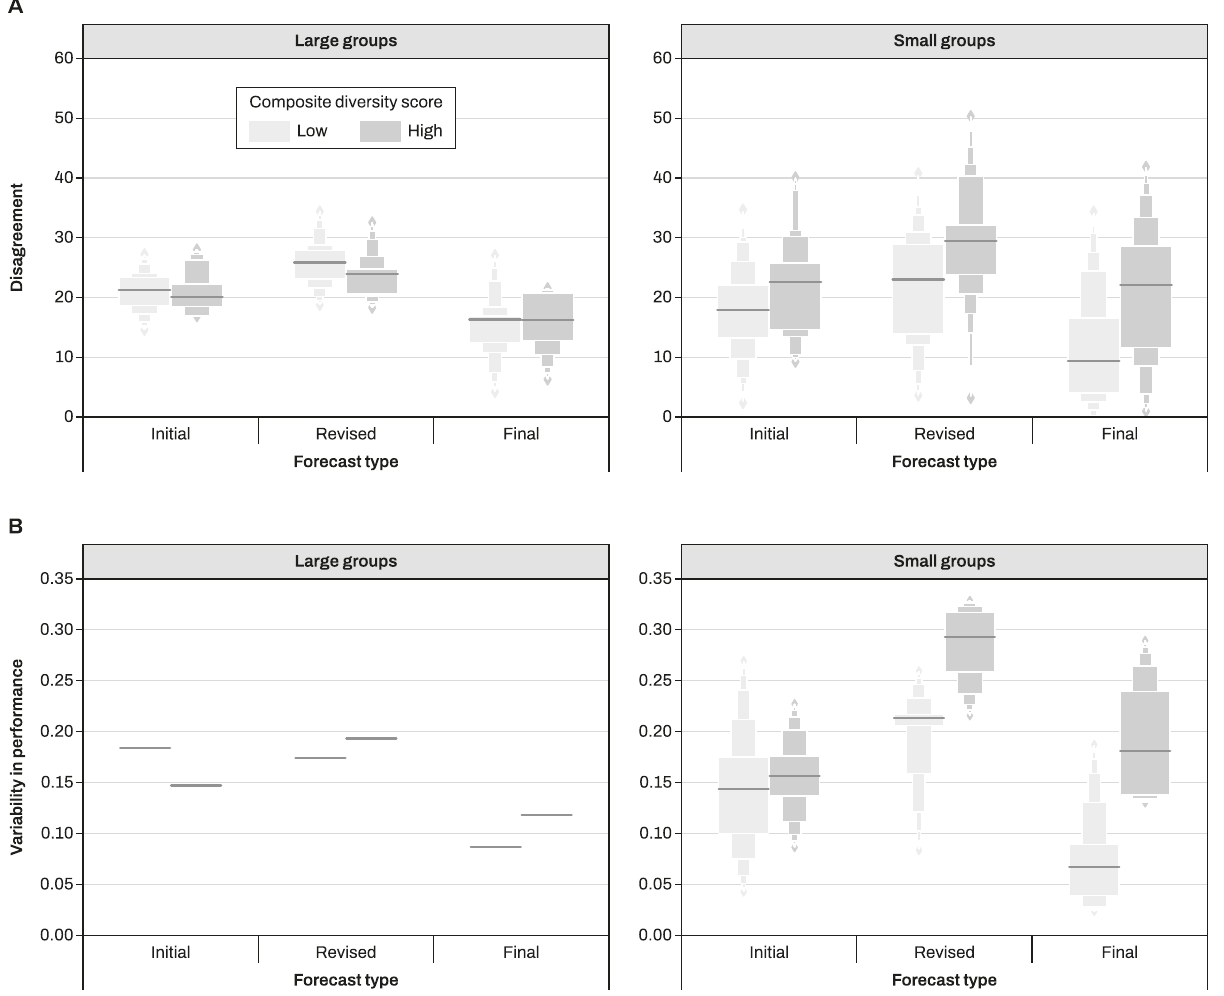
Fig. 4 Disagreement and variability in performance. A Distributions of opinion disagreement as a function of forecasting stage, group trait diversity and group size. Opinion disagreement is calculated as the standard deviation over group members' forecasts. B Performance variability as a function of forecasting stage, group trait diversity, and group size. Performance variability is the standard deviation over average individual performance in a group. Larger values indicate that a group contains members who are very good and members who are quite poor (on average across the eight IFPs). Notice that a single value of performance variability exists for large groups, but not for small groups ( m = 6 and m = 4 for small low and high diversity groups, respectively). Notice also that for both panels consensus forecasts were removed because, by de fi nition, they did not produce meaningful variation in these measures. Box areas correspond to distribution ideal tail areas of 0.50, 0.25, 0.125, 0.0625 (ref. 65 ). Source data are provided as a Source data fi